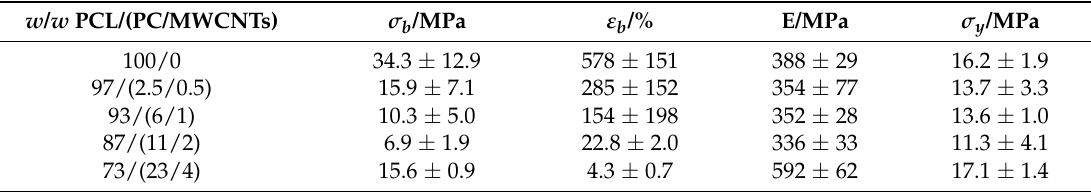
Table 3. Summary of tensile testing results for neat PCL and the nanocomposites.